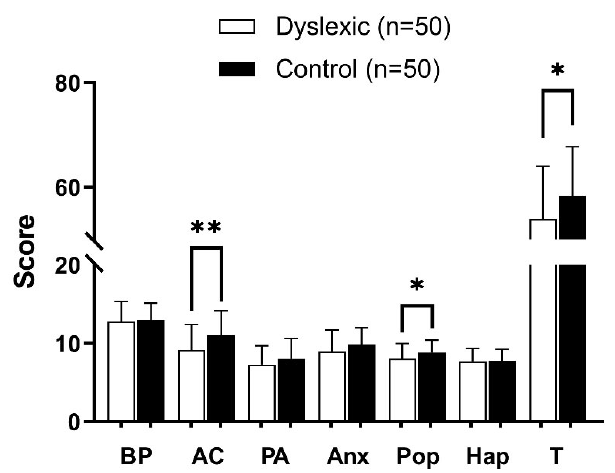
Figure 1. Difference in self-concept score between dyslexic group and control group. Abbreviations: BP, behavior problems; AC, academic competence; PA, physical appearance; Anx, anxious; Pop, popularity; Hap, happiness; T, total self-concept. Note: * p < 0.05; ** p < 0.01.